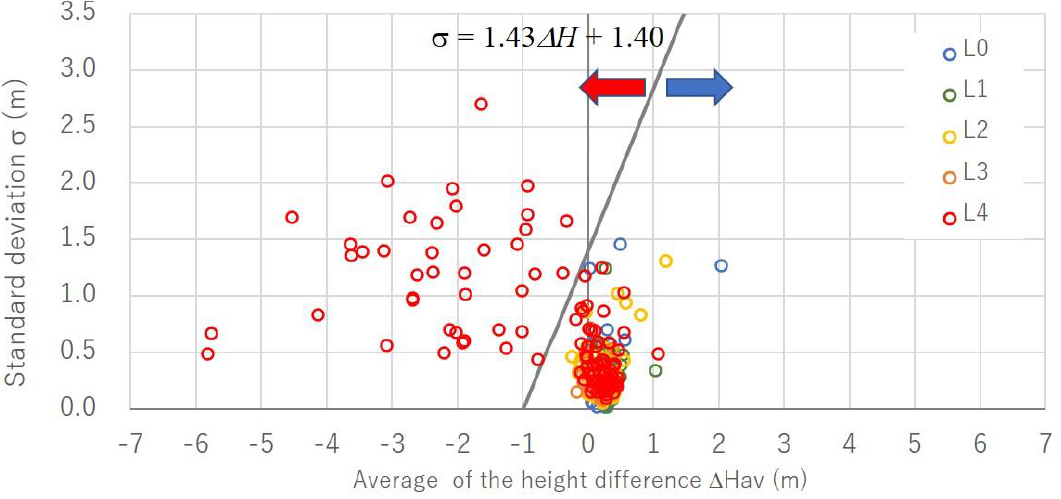
Figure 13. The relationship between the average height difference within the reduced ( − 1.0 m) footprint and the standard deviation of the difference for 396 buildings with five damage levels. The division line ( p = 0.5) between L4 and L0–L3 was obtained by means of logistic regression. Logistic regression [46–49], which is suitable for representing qualitative (such as the damage level) dependent variables, was introduced in order to model the probability ( p = 0.0–1.0) to fall in the major damage level (L4). Consider a two-class problem, L4